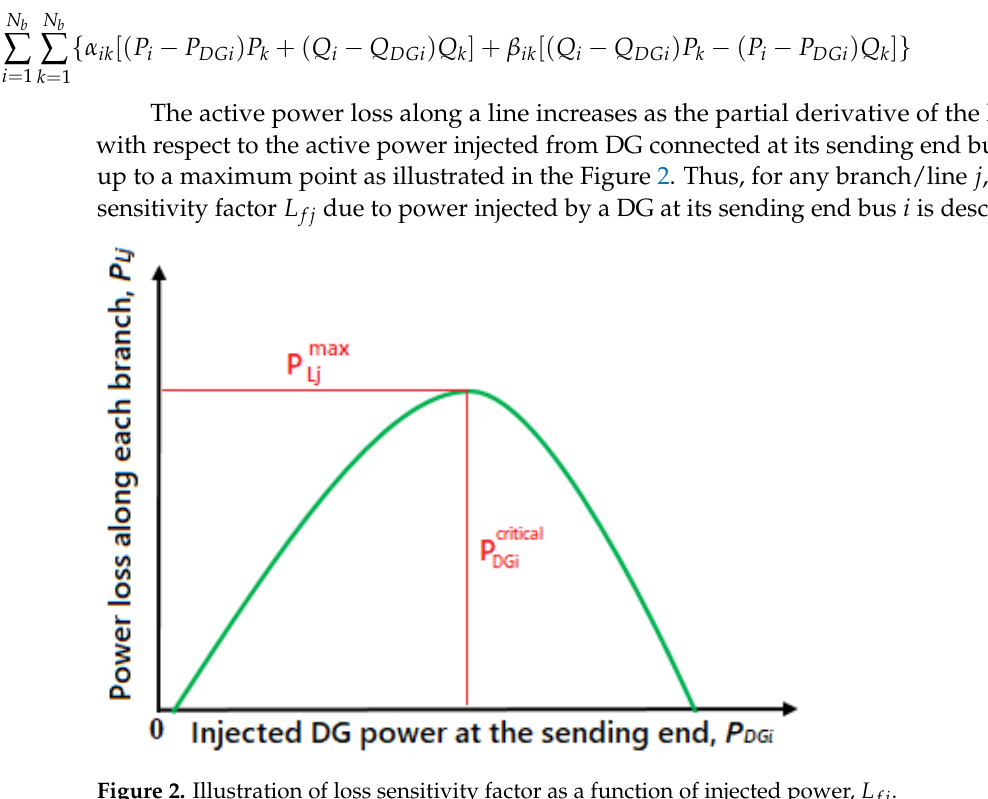
Figure 2. Illustration of loss sensitivity factor as a function of injected power, L fj